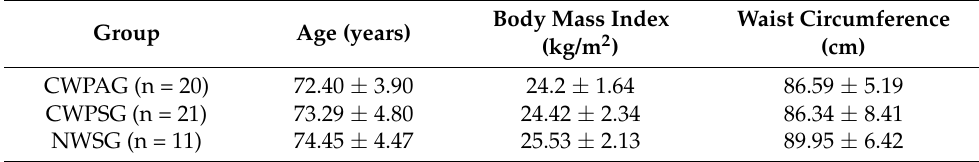
Table 1. Characteristics of study participants.